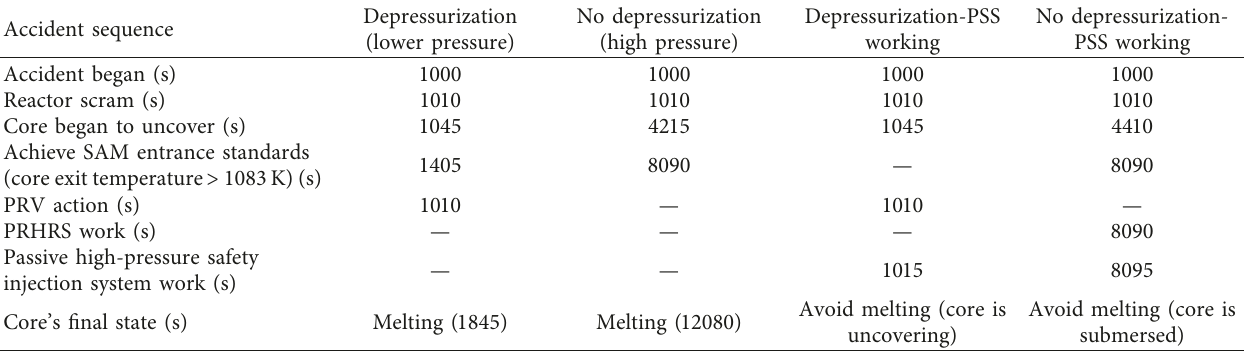
Figure 7: Hydrogen generation rate and total mass in the core. (a) No depressurization. (b) Depressurization. Table 2: Sequence of the different mitigation